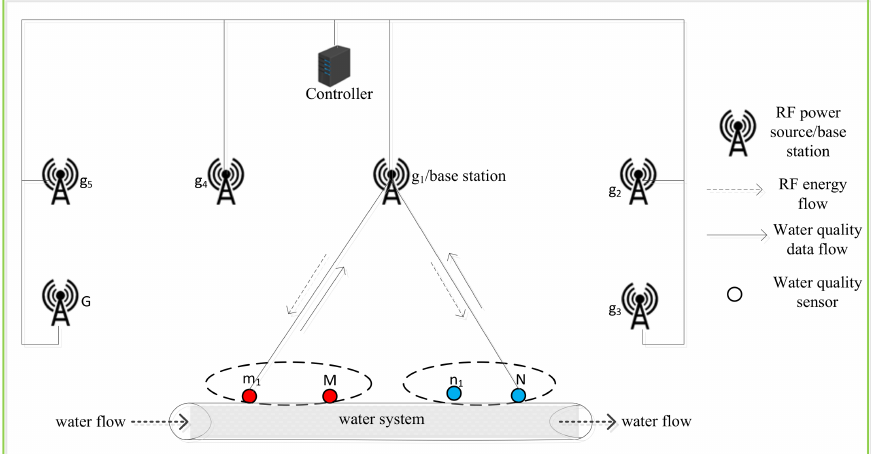
Figure 1. System model for a multi-network wireless information and power transfer (WIPT)